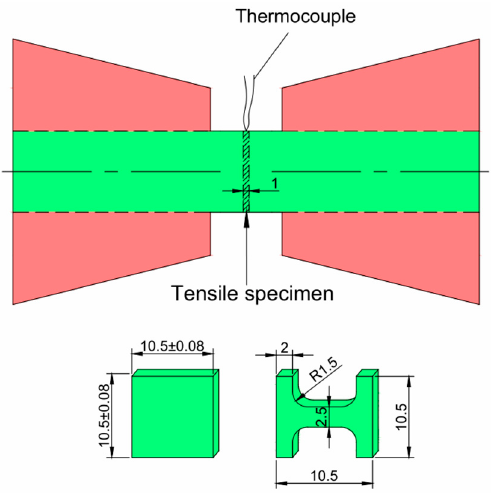
Figure 2. Schematical diagram of the lateral section of the simulated sample for the micro-tensile experiment (in mm).